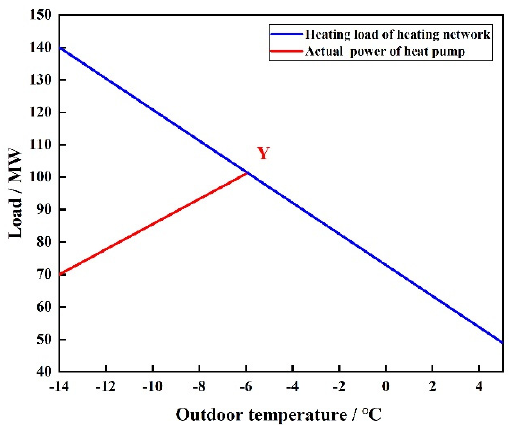
Figure 4. The relationship between the heating load and the outdoor temperature.